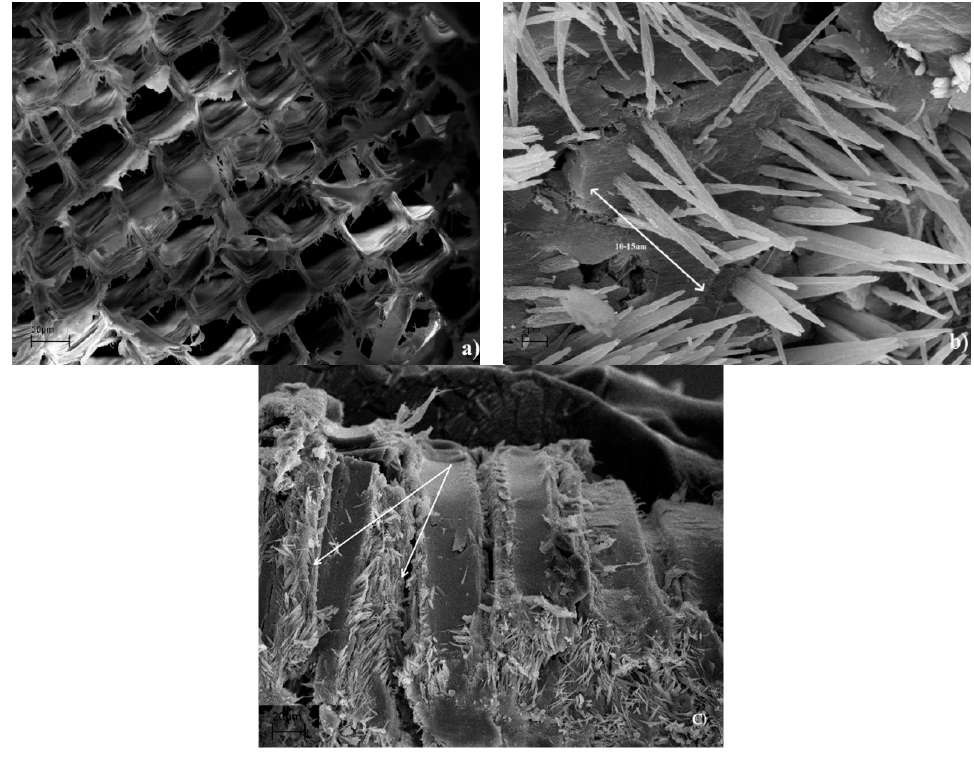
Figure 6. Scanning electron micrographs of wood treated with caffeine ( a ) cross-section, ( b ) needle-shaped caffeine crystals, ( c ) radial cross-section, cellulose fibrils .